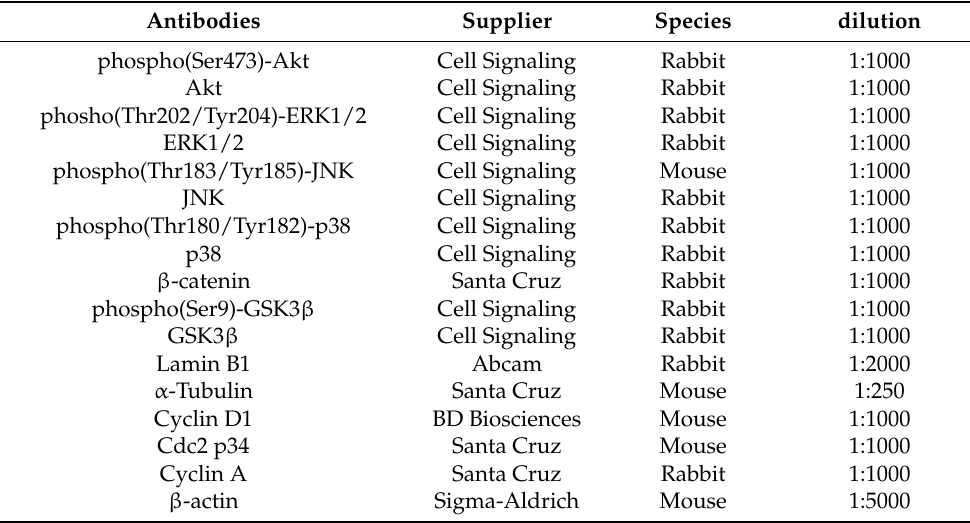
Table 1. List of antibodies used for immunoblotting. Antibodies Supplier Species dilution phospho(Ser473)-Akt Cell Signaling Rabbit 1:1000 Akt Cell Signaling Rabbit 1:1000 phosho(Thr202/Tyr204)-ERK1/2 Cell Signaling Rabbit 1:1000 ERK1/2 Cell Signaling Rabbit 1:1000 phospho(Thr183/Tyr185)-JNK Cell Signaling Mouse 1:1000 JNK Cell Signaling Rabbit 1:1000 phospho(Thr180/Tyr182)-p38 Cell Signaling Rabbit 1:1000 p38 Cell Signaling Rabbit 1:1000 β -catenin Santa Cruz Rabbit 1:1000 phospho(Ser9)-GSK3 β Cell Signaling Rabbit 1:1000 GSK3 β Cell Signaling Rabbit 1:1000 Lamin B1 Abcam Rabbit 1:2000 α -Tubulin Santa Cruz Mouse 1:250 Cyclin D1 BD Biosciences Mouse 1:1000 Cdc2 p34 Santa Cruz Mouse 1:1000 Cyclin A Santa Cruz Rabbit 1:1000 β -actin Sigma-Aldrich Mouse